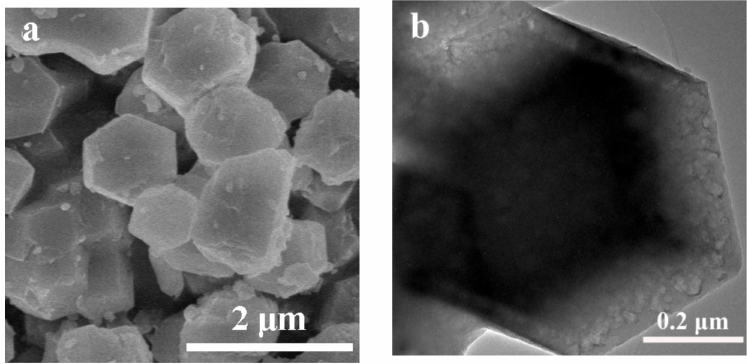
Figure 1. ( a ) SEM image and ( b ) TEM image of